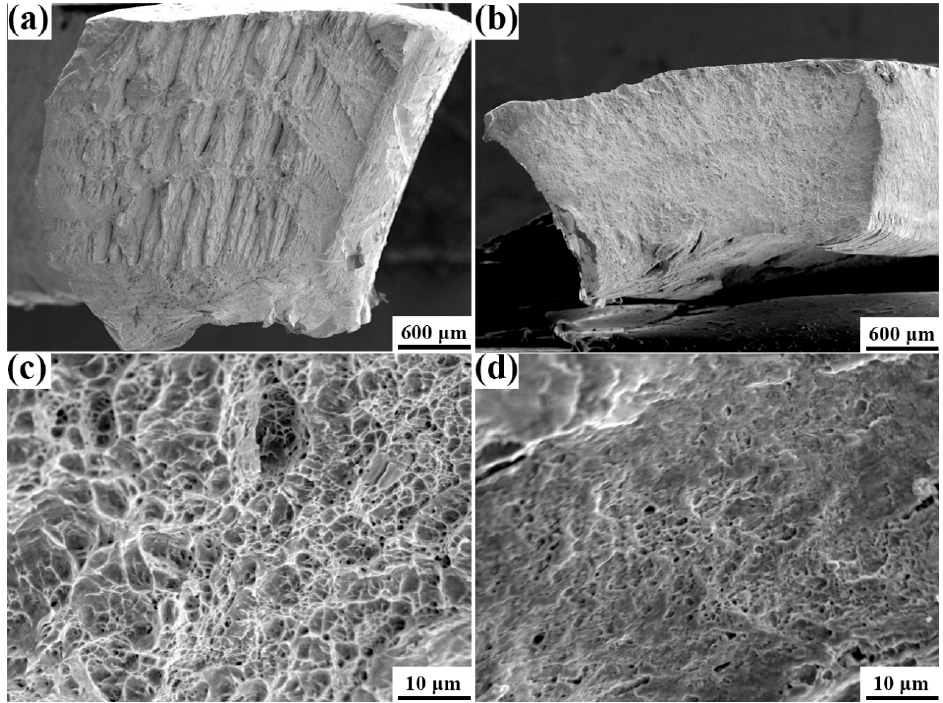
Figure 15. SEM fractographs of specimen A ( a , c ), specimen C ( b , d ). Table 5. The max m’ corresponding to the 16 variant pairs calculated by the STABIX Matlab toolbox. Variant Pairing to V1